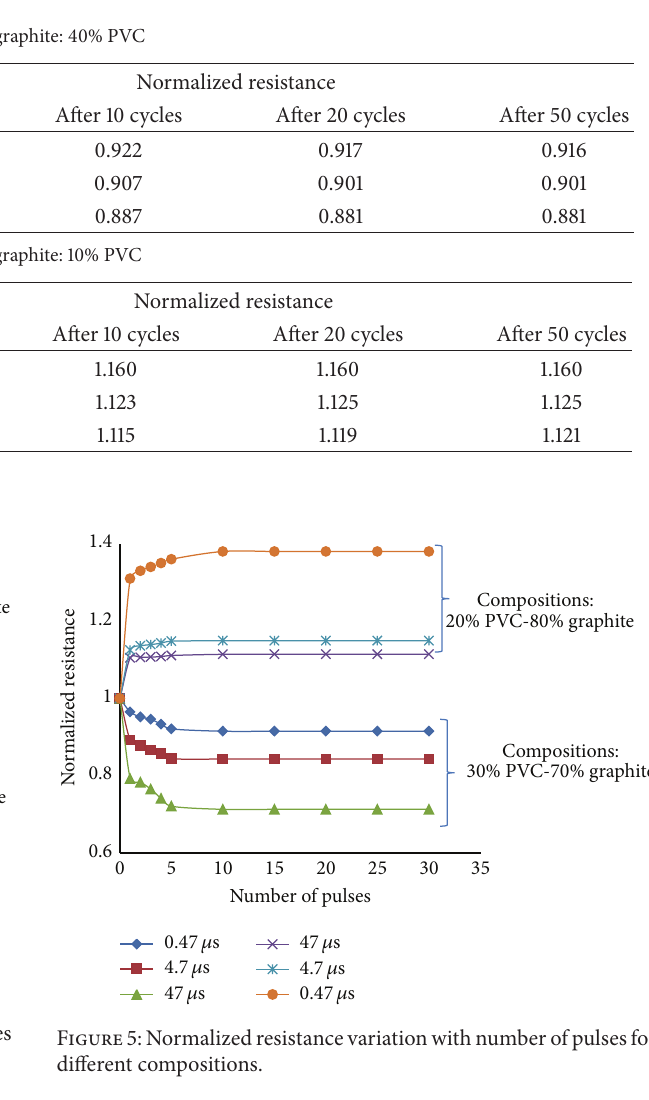
Table 3: Resistance variation with high voltage pulses with different pulse durations of polymer thick film resistors with pulse amplitude = 260 V and pulse duration = 0.47 𝜇 s, 4.7 𝜇 s, and 47 𝜇 s for different PVC-graphite compositions.